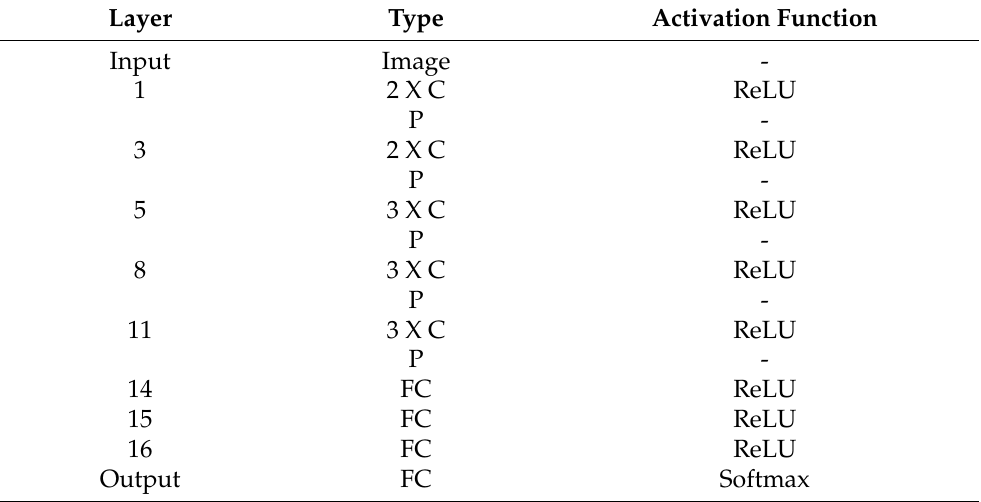
Table 3. Description of VGG-16 architecture (C—convolutional layer, P—Max pooling, and FC—fully